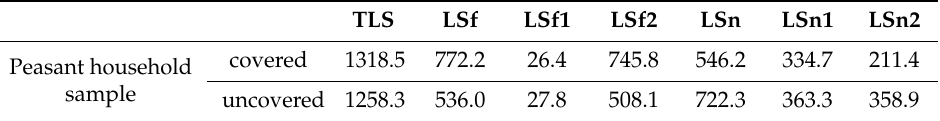
Table 3. Health insurance coverage and labor supply time (hourly / year) in